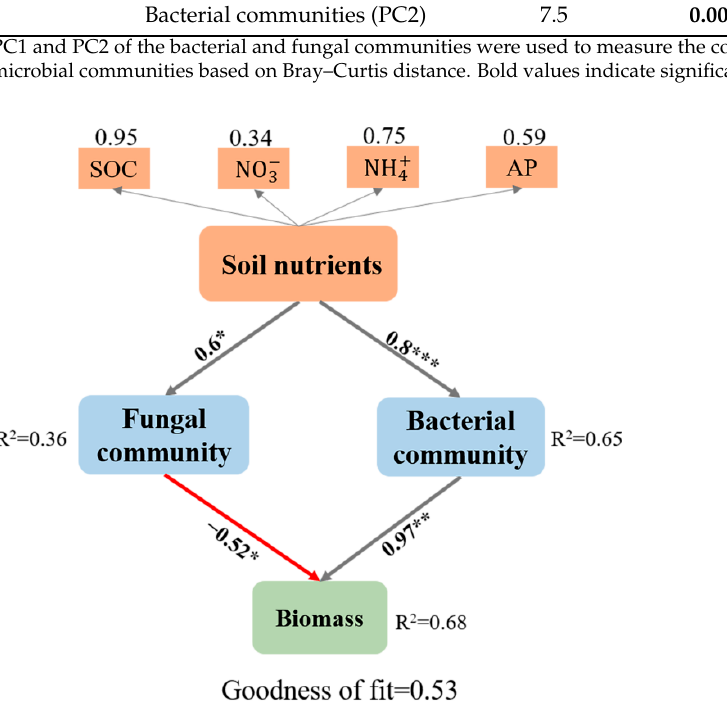
, soil nitrate nitrogen; NH + , soil ammo- 3 4